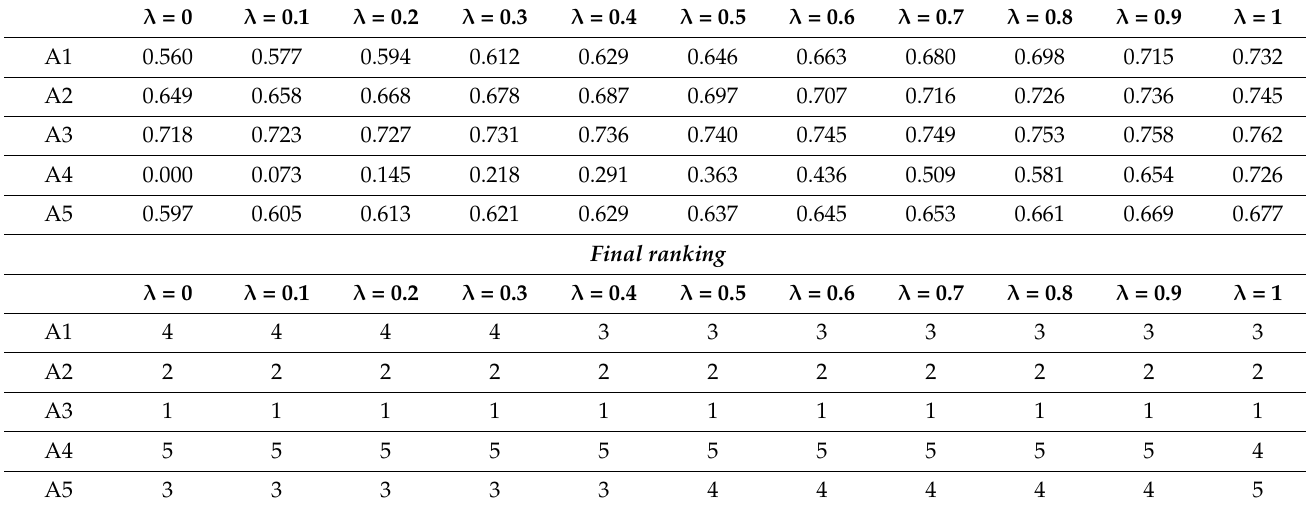
Table 17. Sensitivity